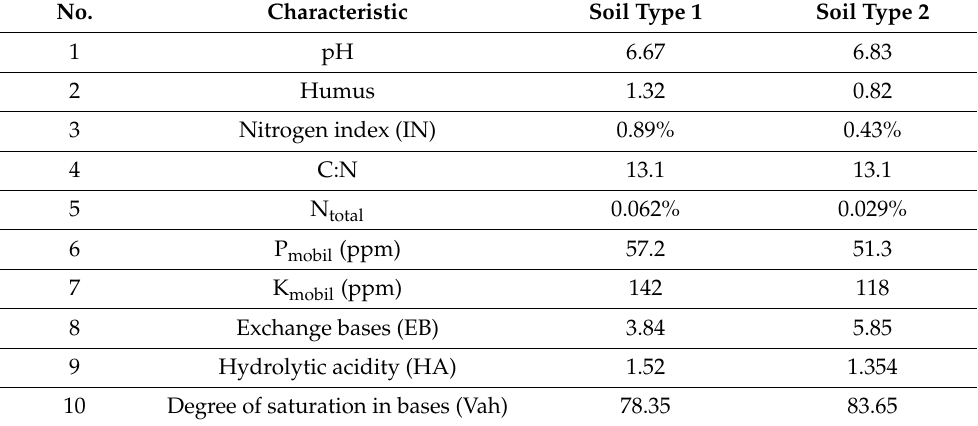
Table 4. Soil characteristics after the application of the sewage sludge and of calcareous